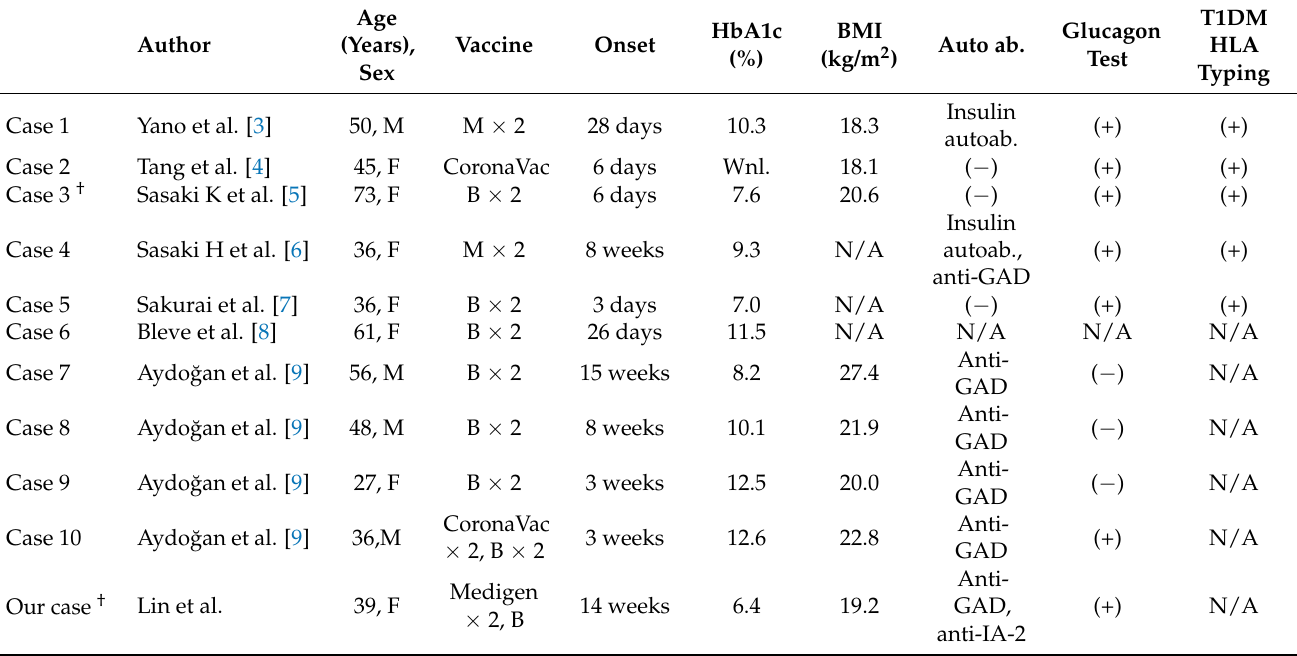
Table 2. Relevant case reports of post-vaccination type 1 diabetes